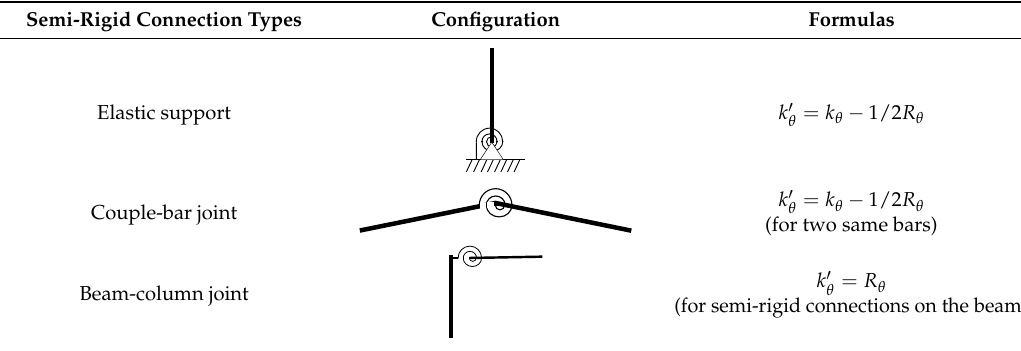
Table 1. Specific formulas for modifying rotational stiffness for three semi-rigid connection types.